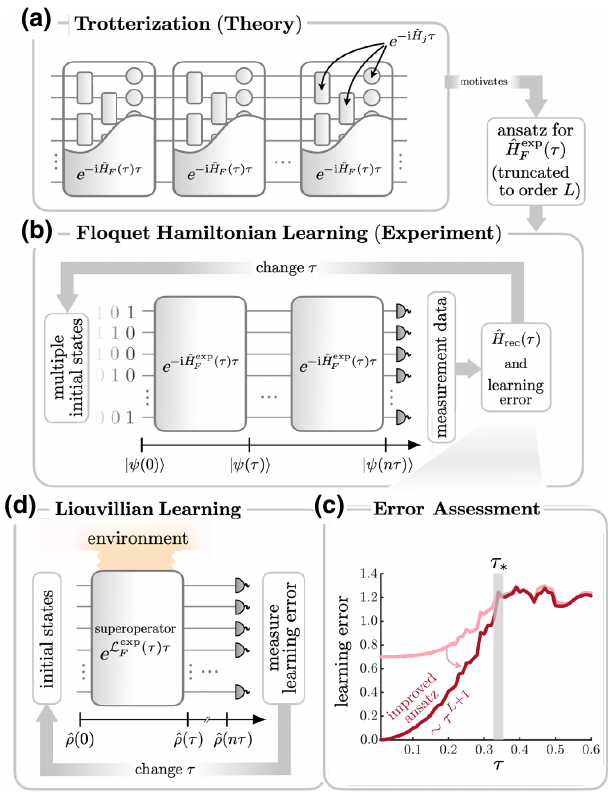
FIG. 1. Process tomography of Trotter blocks. (a) Represen- tation of the Trotter blocks (2) that Trotterized DQS aims at implementing. The generator of each Trotter block is the FH ˆ H (τ)τ (multiplied by the Trotter step), defined via Eq. (3). F (b) Trotter blocks implemented in experiments are affected by control errors: they are treated as “black boxes” to be charac- terized by our protocol. The protocol aims at learning the FH ˆ H exp (τ) from measurements performed on a set of initial states, F after repeated application of the Trotter blocks. The measure- ments are used to fit an ansatz for a truncation of ˆ H exp given order L in τ . The procedure is repeated for several values of τ . (c) The corresponding learning error is measured as a func- tion of τ : if it scales as τ L + 1 (for τ < τ ∗ ) then the reconstruction is successful. The data presented in (c) are obtained from the pro- tocol applied to a DQS of the Heisenberg model, Eqs. (14) and (15), for learning up to order L = 1 of the FH. (d) The procedure can be generalized to learning Floquet Liouvillians L exp presence of dissipation (see Sec.